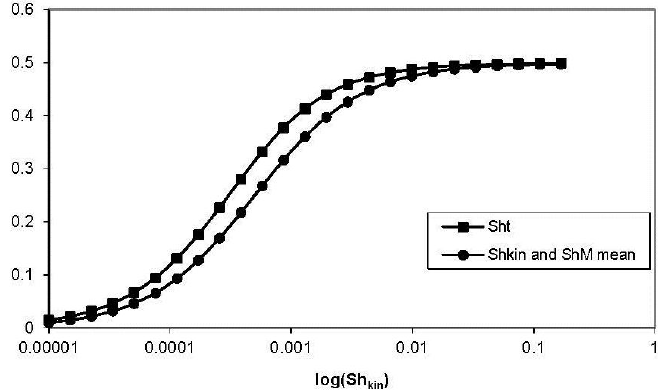
Figure 9. Errors introduced by using the harmonic mean between Sh kin and Sh M . (B/D = 1; H/D = 0.1; x A1 = x A2 ; Pe y =